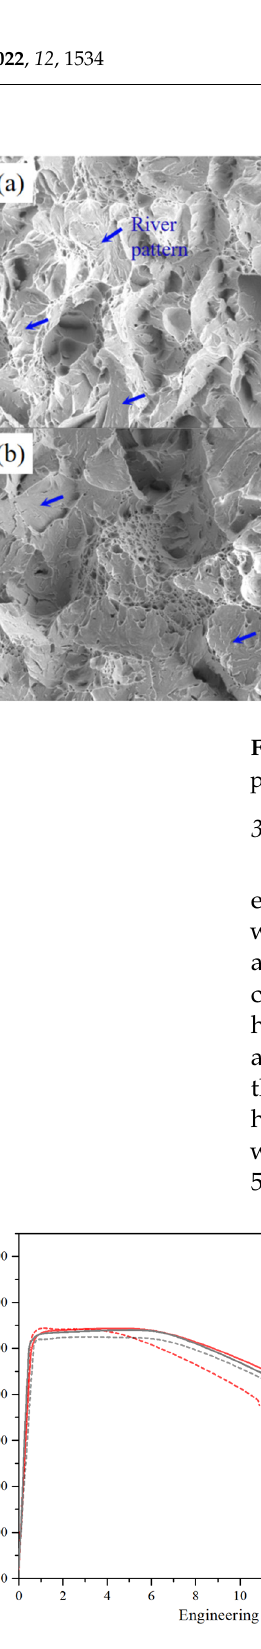
Figure 17. ( a ) Engineering stress-strain curves of hydrogen-free and hydrogen-charged samples. ( b ) Comparison of elongation and reduction of area of the two steels before and after hydrogen charging and the assessed hydrogen embrittlement susceptibility indexes.